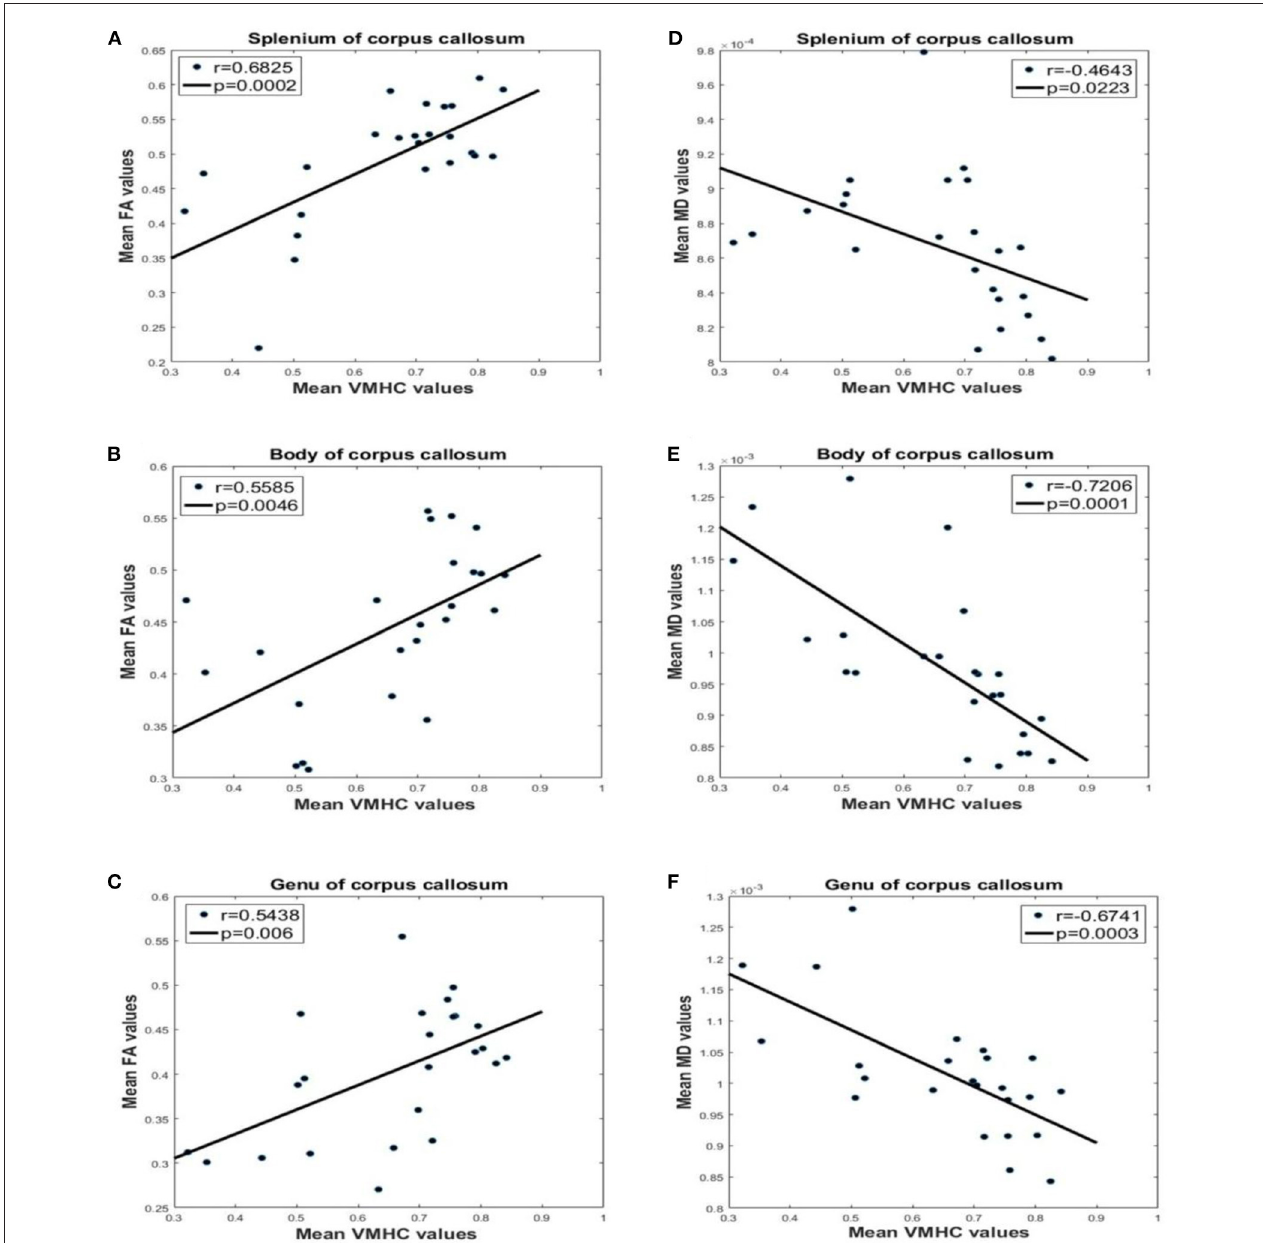
FIGURE 6 | Correlation analysis between FA, MD, and VMHC values for different parts of the CC. VMHC and FA in the (A) splenium, (B) body, and (C) genu. VMHC and MD in the (D) splenium, (E) body, and (F) genu.